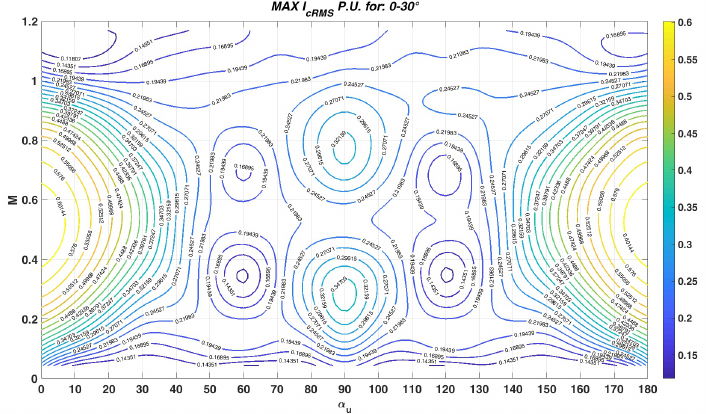
in p.u with respect to the rms value of the phase rms